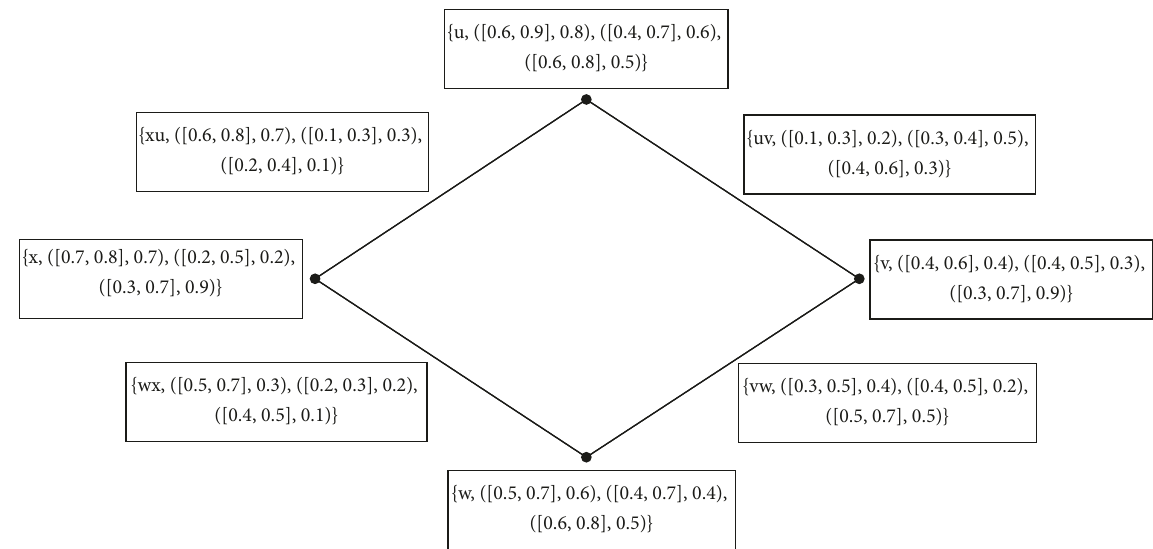
Figure 8: G is SETI-NCG but it is not